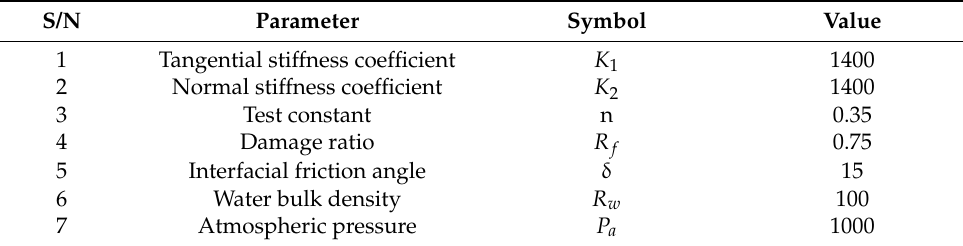
Table 3. Parameters of Goodman element between the concrete and the dam